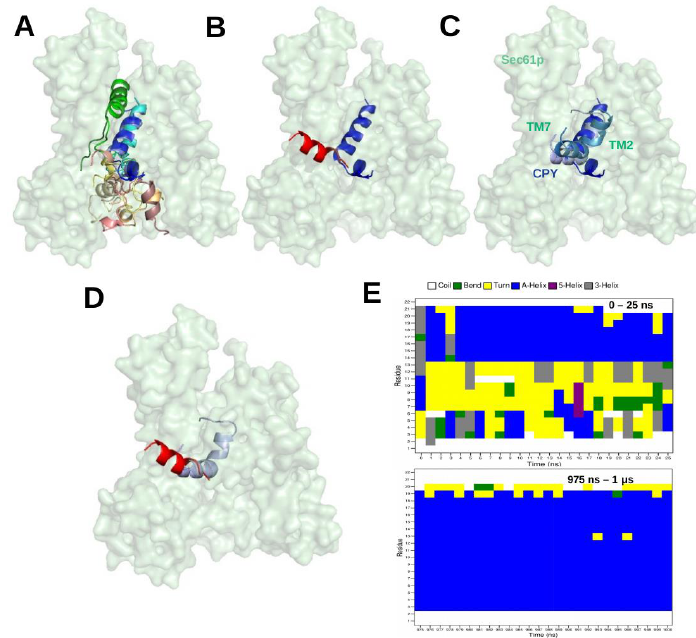
2 Figure 5. ( A ) The top ten ranked docking positions of the signal peptide (SP) of Carboxypeptidase